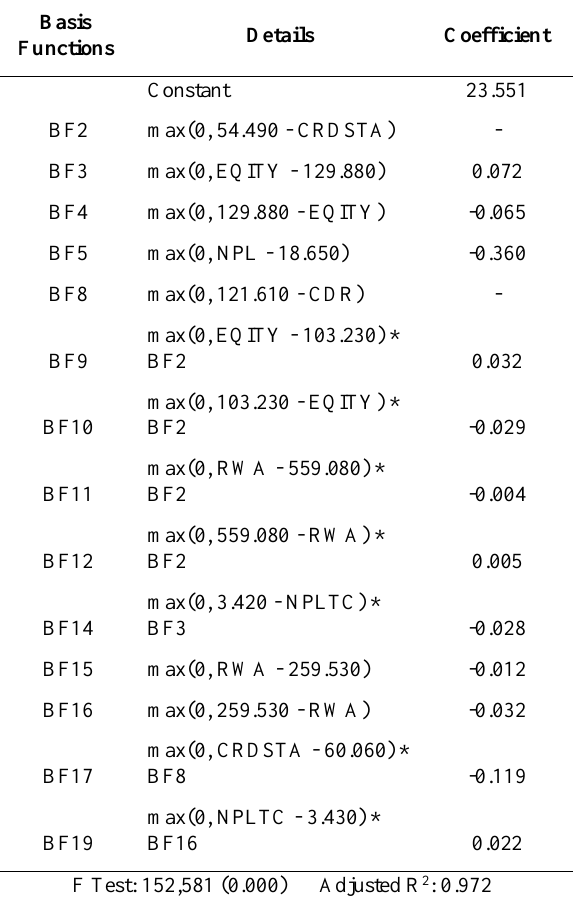
Table 4: CAR Basis Functions